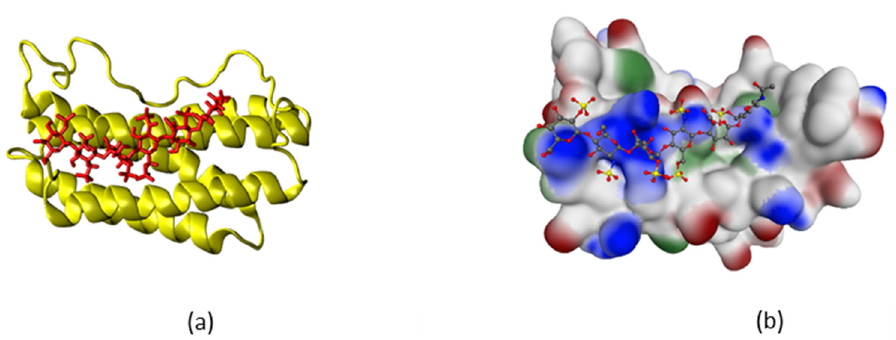
Figure 6. The IL-6/LMWH complex. ( a ) IL-6 in yellow, heparin in red; ( b ) IL-6 molecule presented with its SAS (hydrophobic regions in green, positively charged regions in blue, and negatively charged regions in red), heparin coloured by atom type.